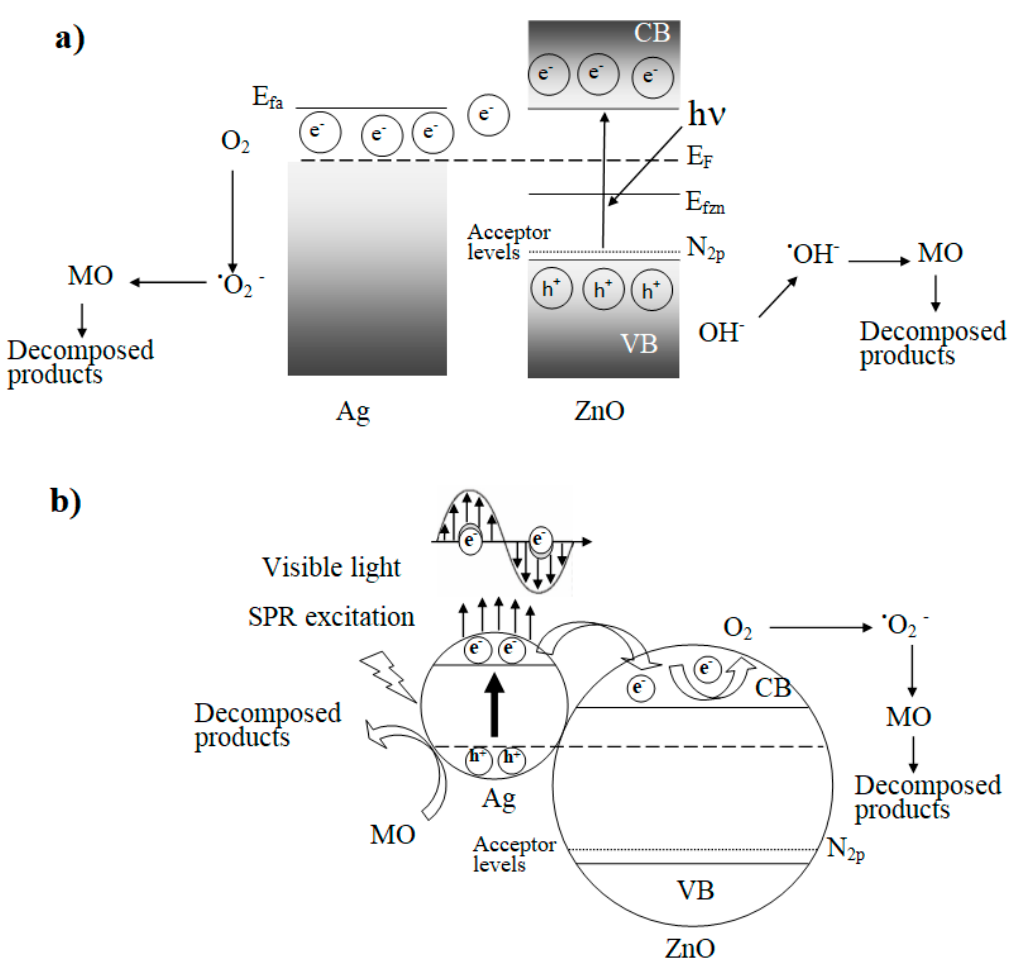
Figure 8. Schematic band diagram of ZnO:N-Ag nanostructures showing the processes for the photocatalytic degradation of MO dye under ( a ) UV light irradiation and ( b ) visible light irradiation. The overall reactions under the UV and Visible photocatalytic reaction are shown below [45]: ZnO nanorod + ℎ𝜈(UV) → ZnO(e (cid:2887)(cid:2886)(cid:2879) + h (cid:2906)(cid:2886)(cid:2878) ) ZnO nanorod/Ag nanorod + ℎ𝜈(Visible) → ZnO nanorod /Ag ∗ (e (cid:2879) )